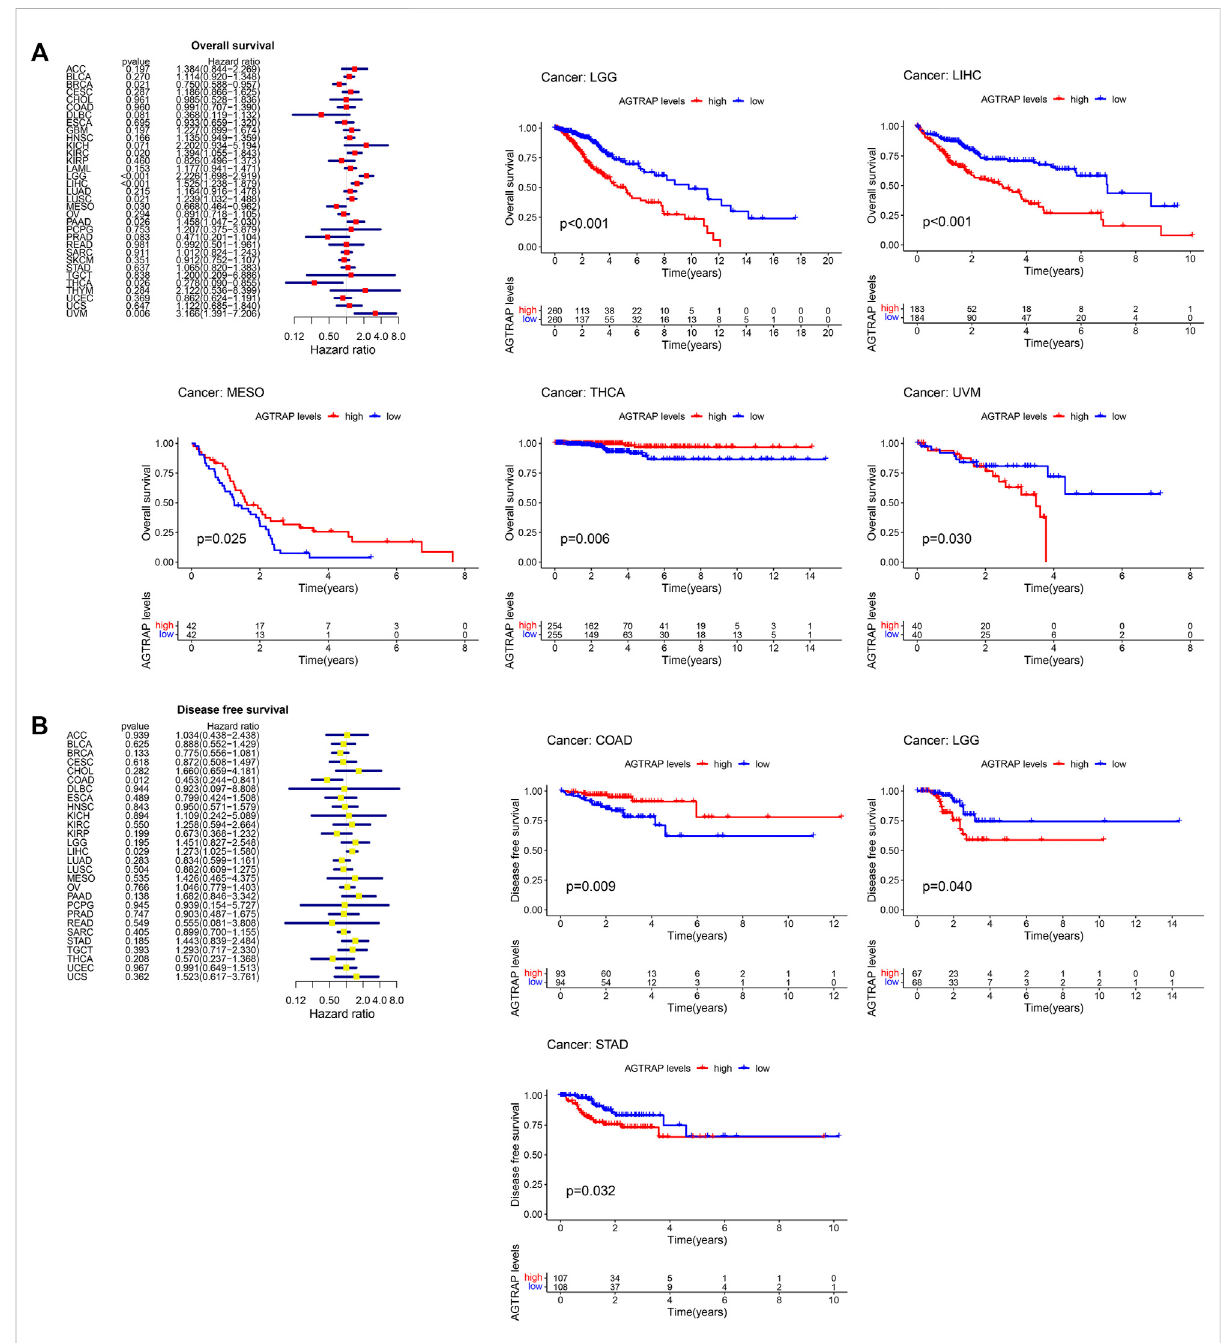
FIGURE 3 Correlation between the expression of AGTRAP and prognosis in pan-caner. (A) Relationship of overall survival (OS) and AGTRAP expression in pan-cancer. (B) Relationship of disease-free survival (DFS) and AGTRAP expression in pan-cancer.